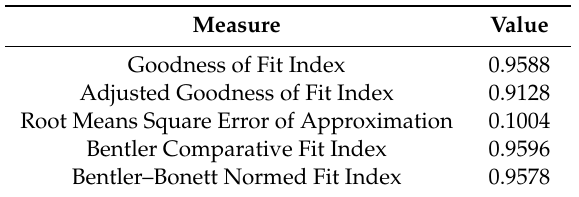
Table 3. Fit summary statistics of confirmatory factor analysis for structural validity of Physical Component Summary Score and Mental Component Summary Score in the Short-Form 12-Item Survey—version 2 among an older (65 years or greater) US population 1